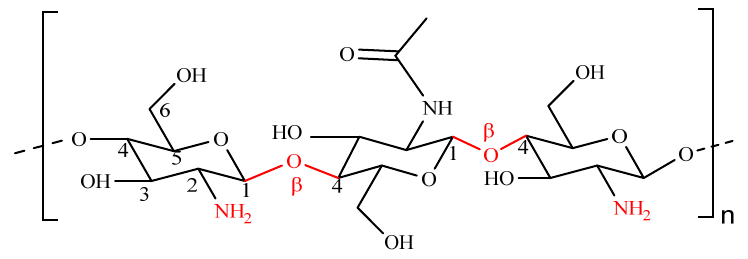
Figure 2. The structure of chitosan.